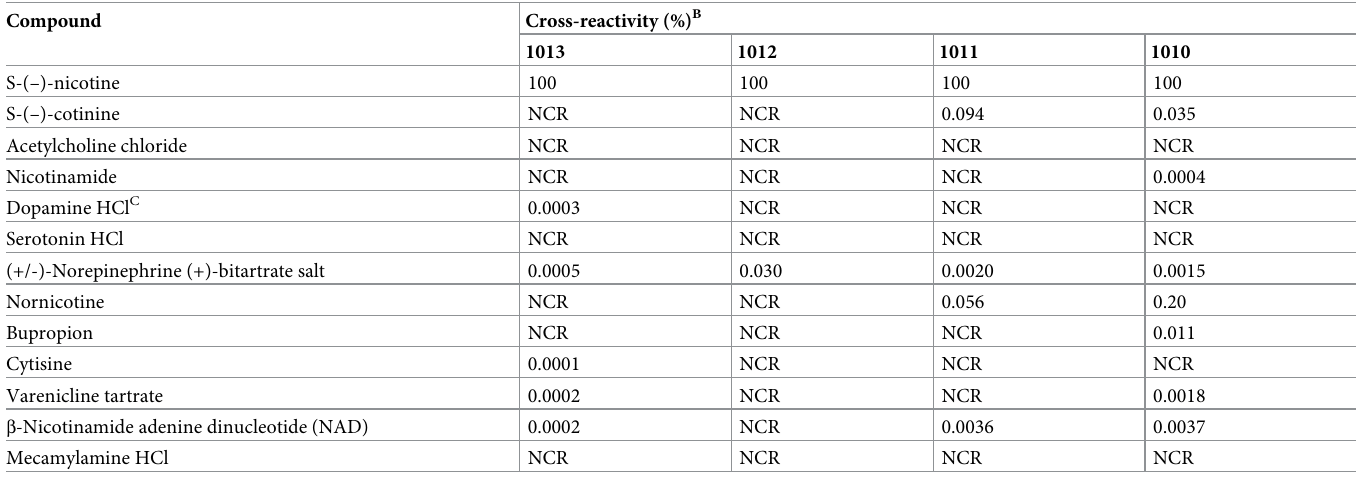
Table 2. Antigen selectivity of the 4 nic•mAbs A with highest affinity for